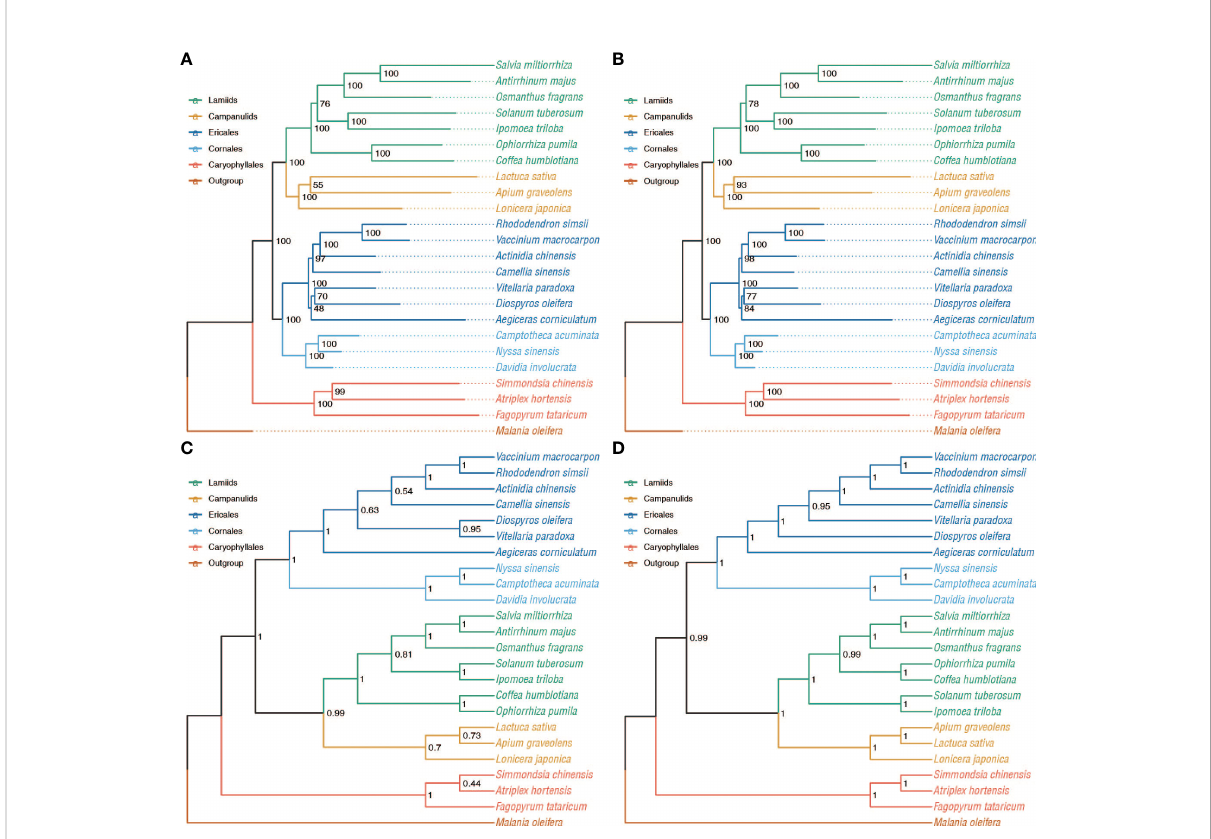
FIGURE 2 Phylogenetic relationships inferred from the 34 single-copy orthogroups and 532 low-copy orthogroups with concatenation and coalescent- based approaches. Bootstrap support (BS) values are shown. (A) Concatenation-based inference using the CDS sequence alignment from 34 single-copy orthogroups. (B) Concatenat-based inference using the amino acid sequence alignment from 34 single-copy orthogroups. (C) Coalescent-based inference using the amino acid sequence alignment from 34 single-copy orthogroups. (D) Coalescent-based inference using the amino acid sequence alignment from 532 low-copy orthogroups with Bootstrap support (BS) values ≥